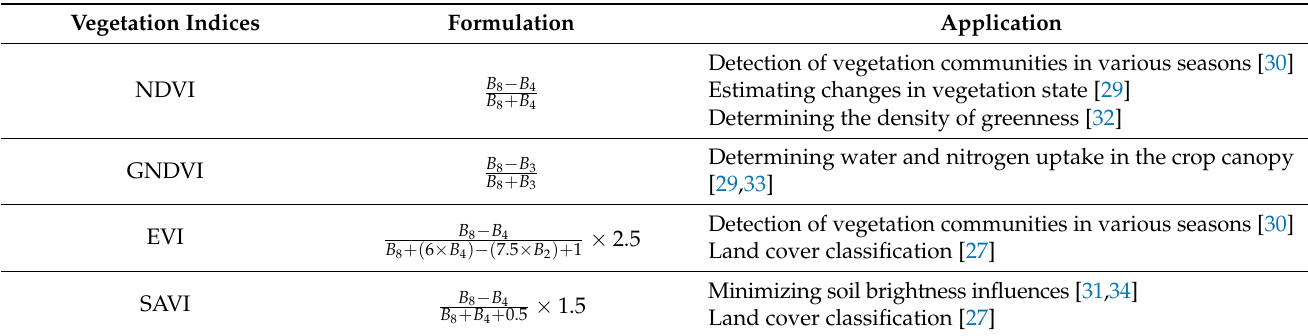
Table 1. Vegetation indices (VIs) and applications from S2A.